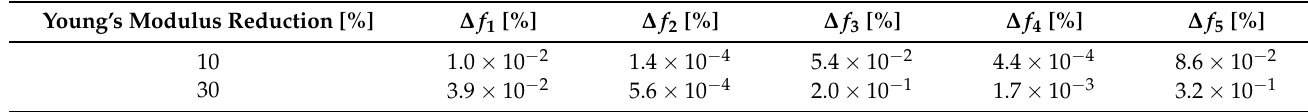
Table 2. List of ∆ f i values used to simulate